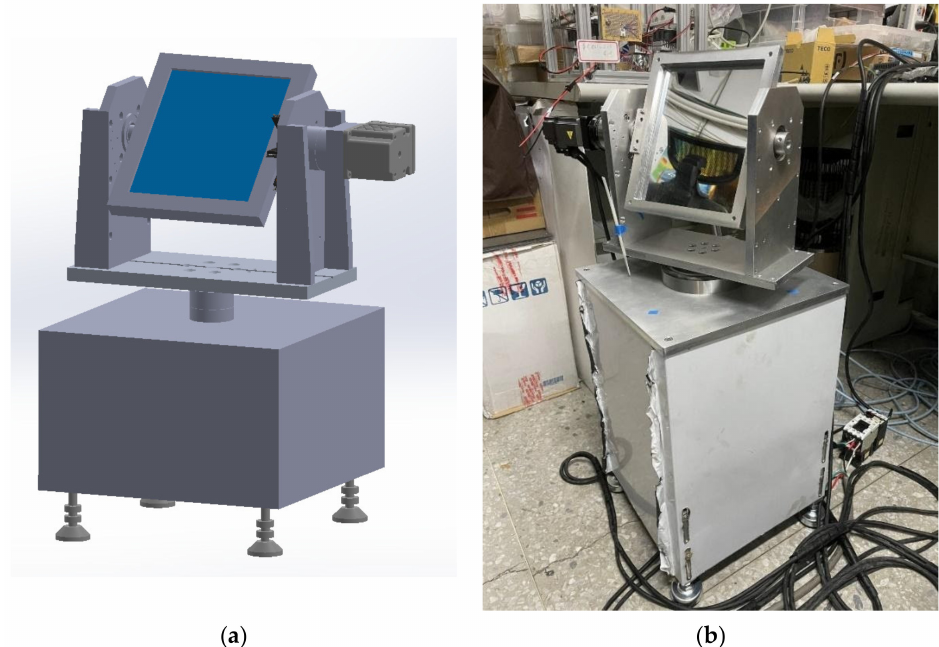
Figure 9. ( a ) CAD model of the heliostat module; and ( b ) heliostat module built with a stainless steel outer